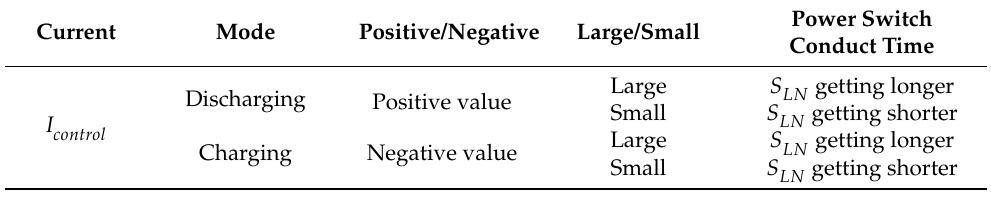
Table 3. Uniform charge and discharge control switch on time comparison table (N ≥